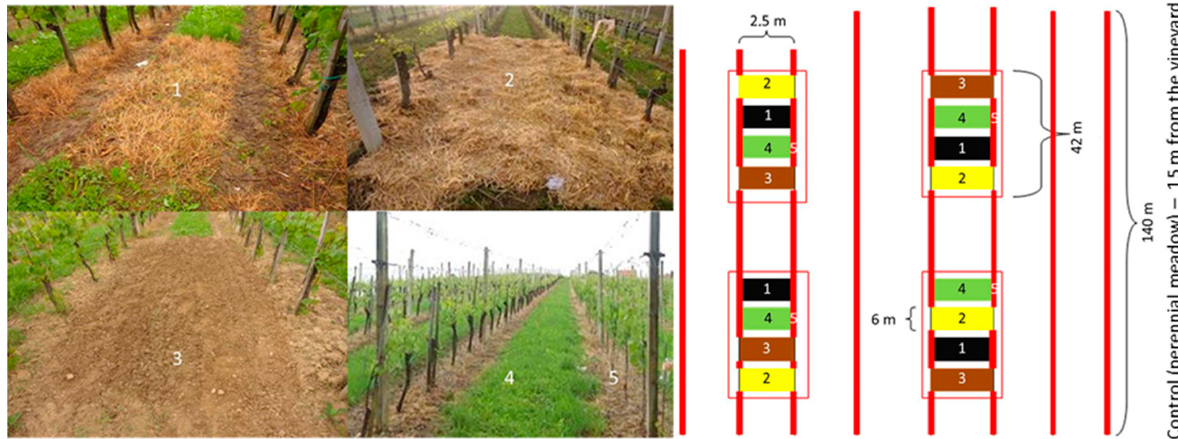
Figure 1. Different soil management practices. (1) herbicide, (2) mulch, (3) tillage, (4) green cover, (5) herbicide strip (left in the vineyard, right the experiment plan sketch). Picture is original (photo Marko Breznik).